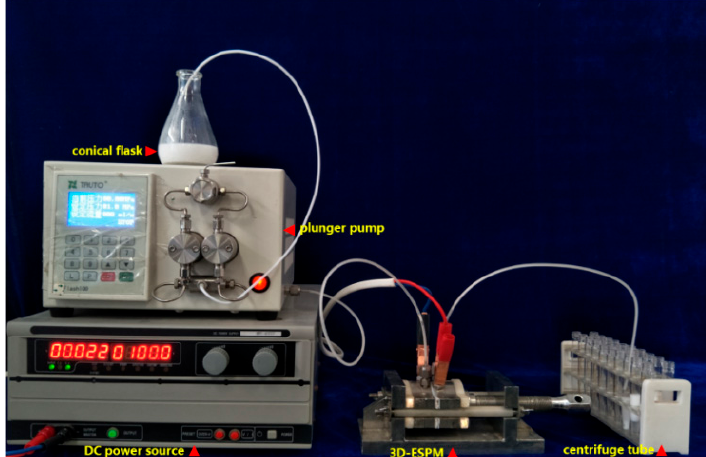
Figure 1. Photograph of the three-dimensional electric spiral plate-type microchannel (3D-ESPM) experimental setup.